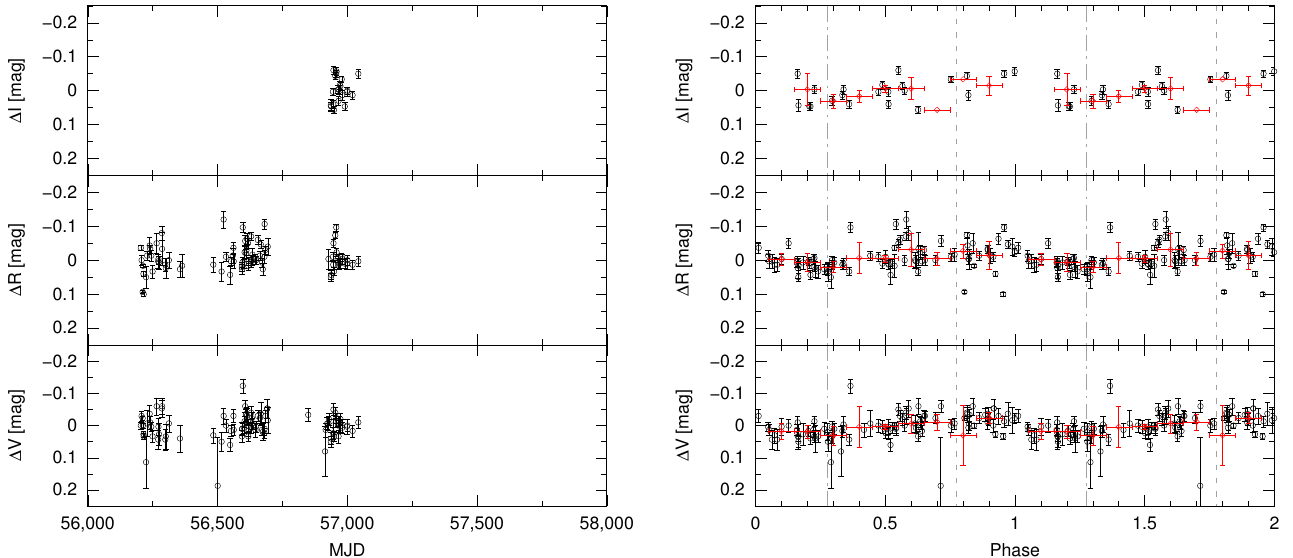
Figure 2. Optical photometry of LSI + 61 303 with Kanata/HOWPol. From top to bottom, differential magnitude in the I , R , and V bands are plotted. The left and right panels show the variation over the entire observational period and that folded with the orbital period [11]. In the right panel, the data in a bin of 0.1 of phase are overplotted with red points. The data are plotted for two cycles in the right panel. The vertical dash-dotted and dotted lines indicate the periastron and the